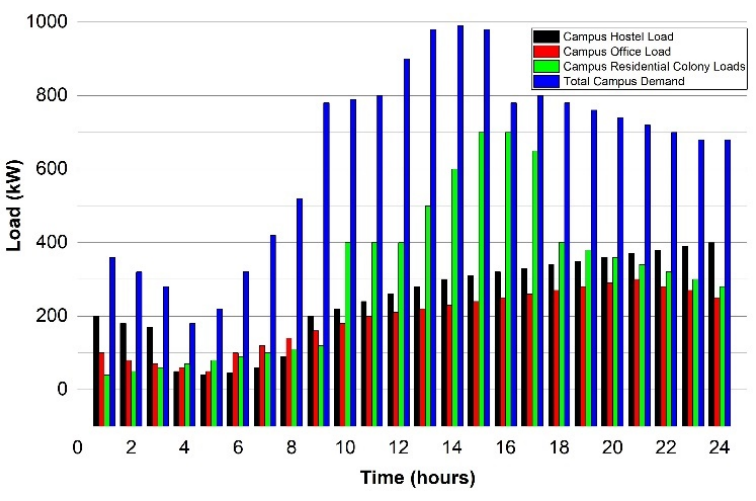
Figure 5. Load pattern behavior of campus.